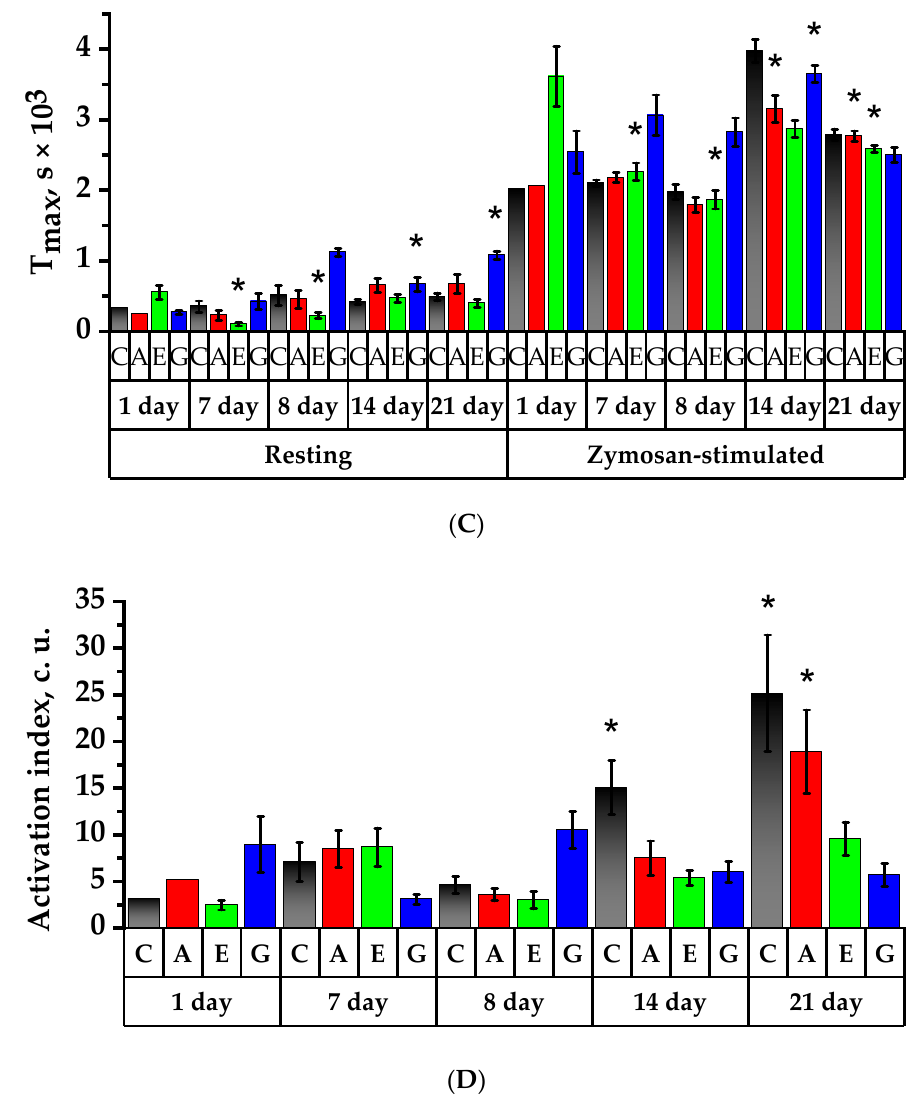
Figure 7. Spontaneous and zymosan-activated CL of rat neutrophils: ( A )—CL intensity (I max , c.u.); ( B )—area under the CL curve (AUC, c.u.); ( C )—the time showing peak CL (T max , c.u.); ( D )—activation index (I act , c.u.). * p < 0.05, significance of differences in animal groups compared to the 1st day of the experiment.